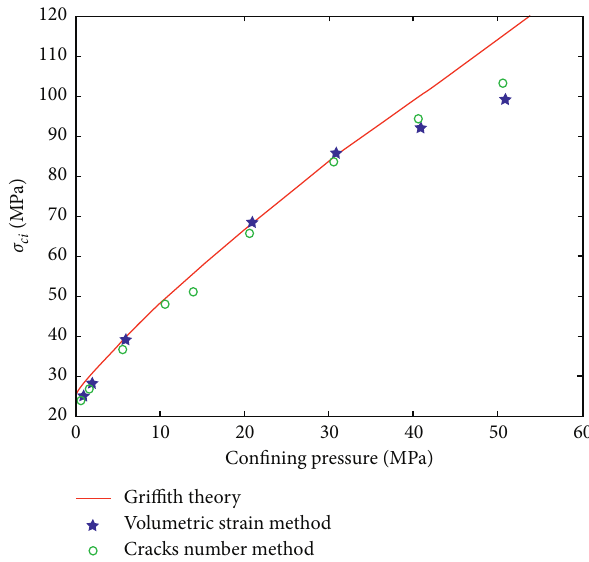
Figure 11: Theoretical and calculated values of σ